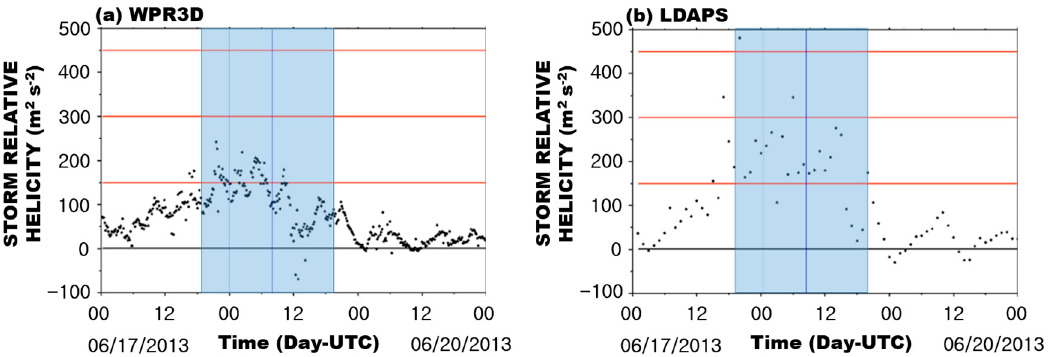
Figure 11. Wind vectors ( a ) from WPR3D and ( b ) from LDAPS at the P0 station.